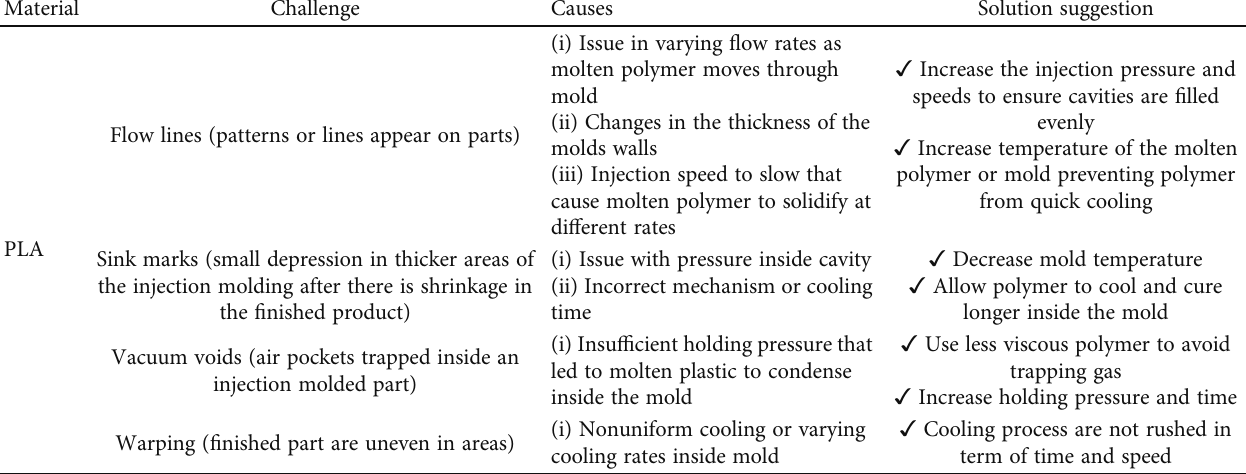
Table 10: Challenge injection molders deals with PLA